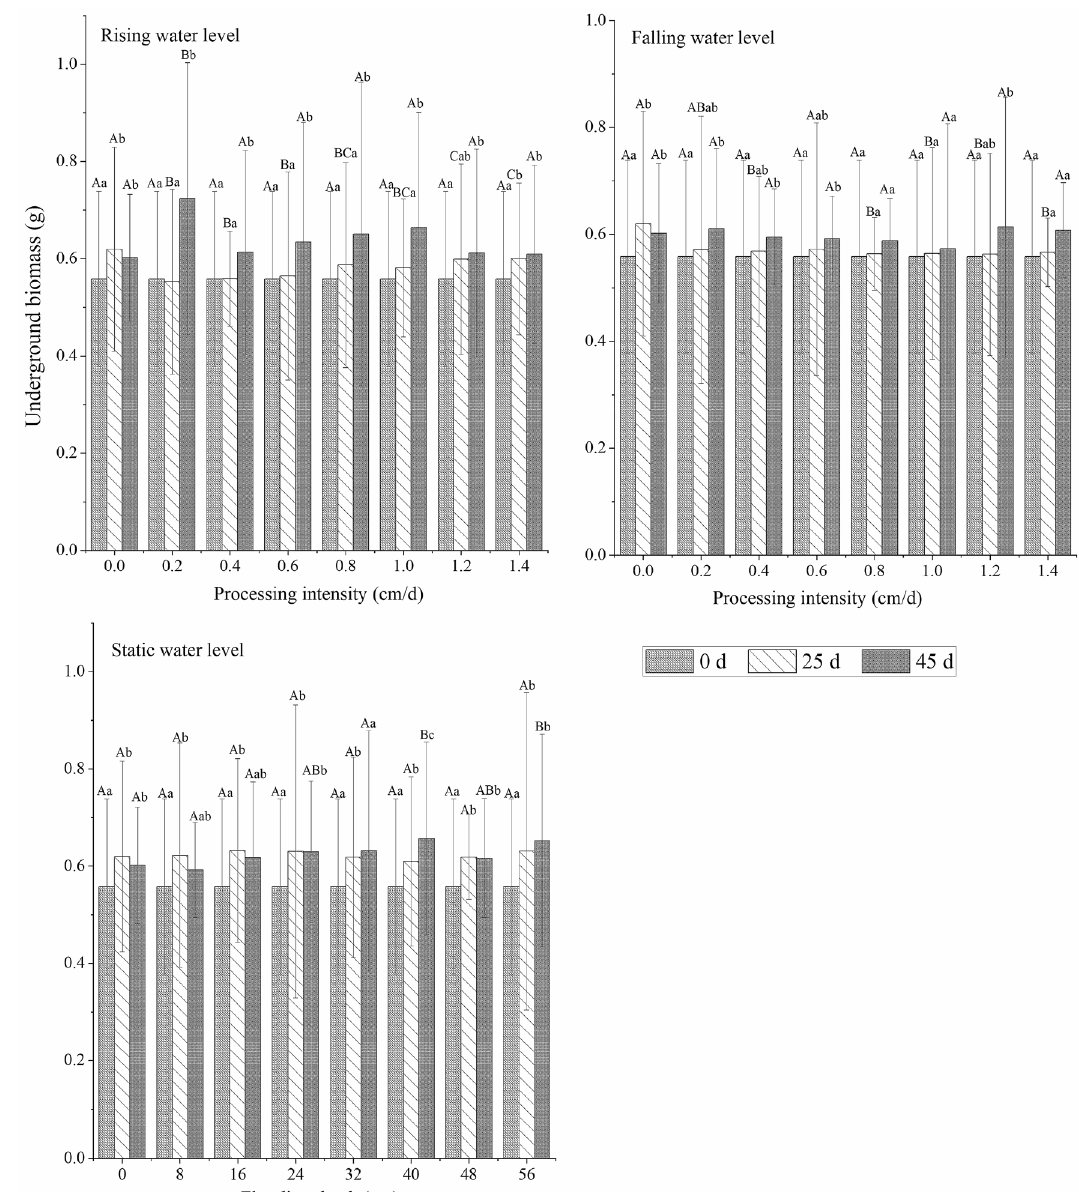
Figure 4. Effects of different hydrological environments on underground biomass and bioavailability of C.